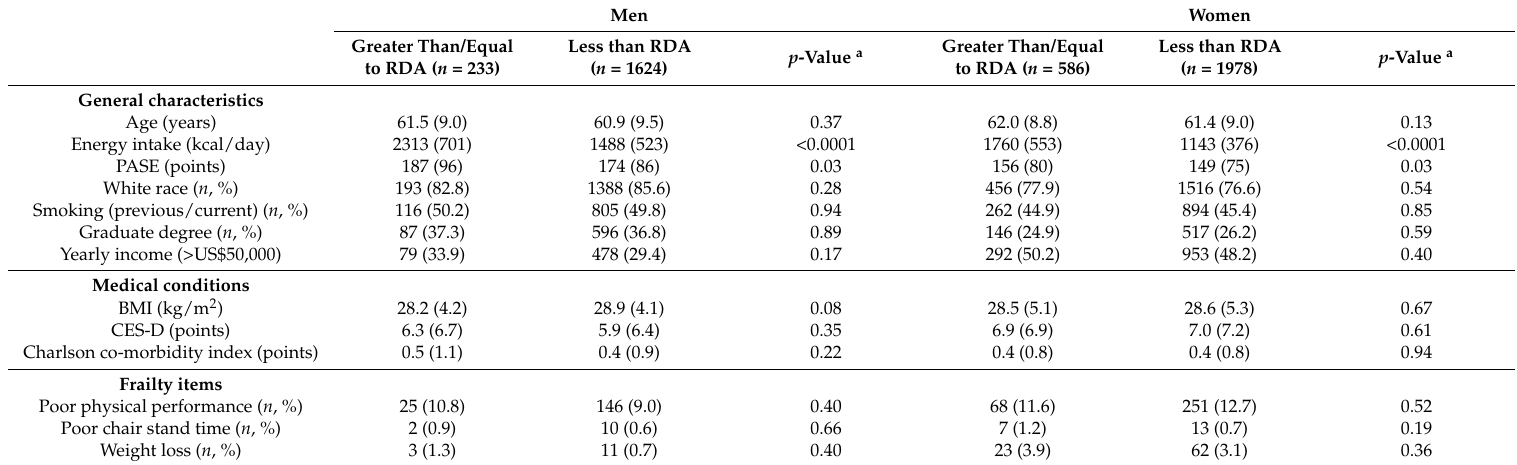
Table 1. Characteristics of the participants classified according to their baseline dietary magnesium intake. Men Women Greater Than/Equal Less than RDA Greater Than/Equal Less than RDA p -Value a p -Value to RDA ( n = 233) ( n = 1624) to RDA ( n = 586) ( n = 1978)